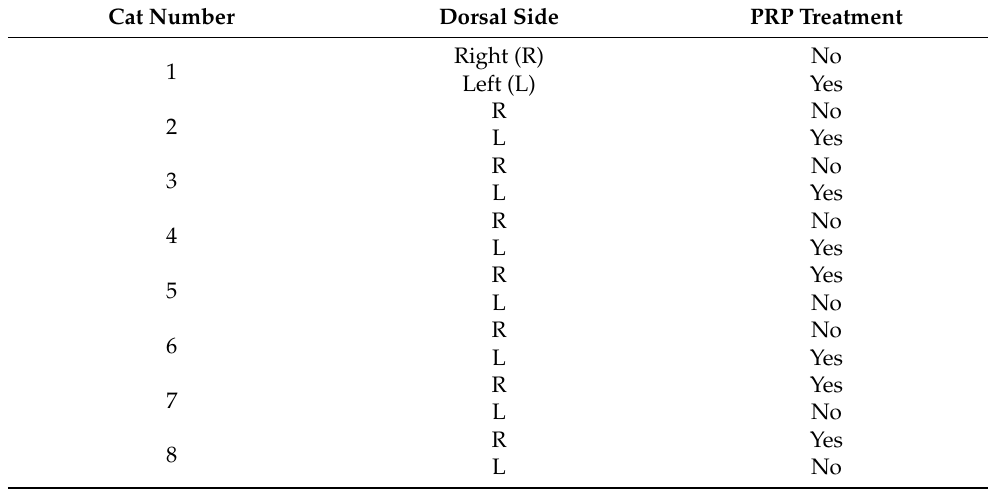
Table 1. Platelet-Rich Plasma injection data in the eight cats. Cat Number Dorsal Side PRP Treatment Right